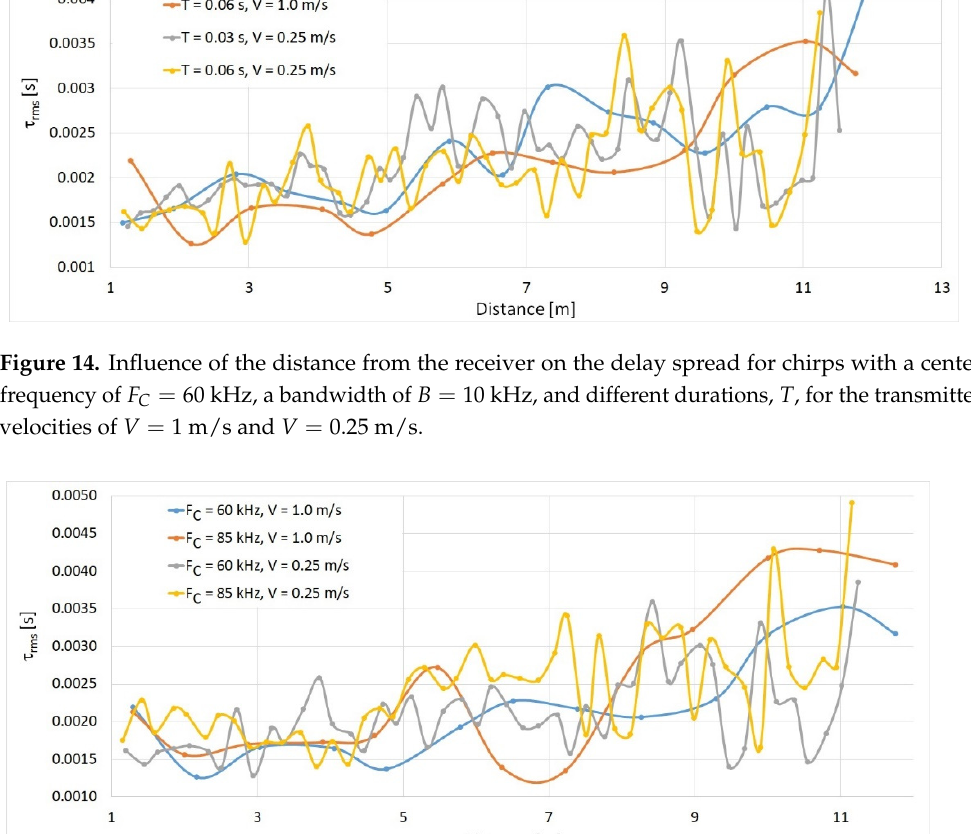
Figure 15. Influence of the distance from the receiver on the delay spread for chirps with a bandwidth of B = 10 kHz, a duration of T = 60 ms, and different center frequencies, F C , for the transmitter velocities of V = 1 m/s and V = 0.25